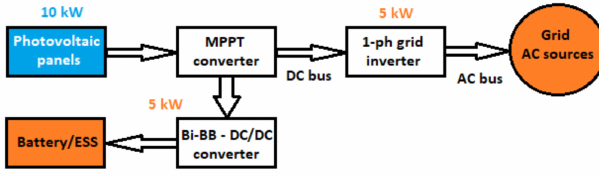
Figure 17. Representation of the operational Scenario 1.